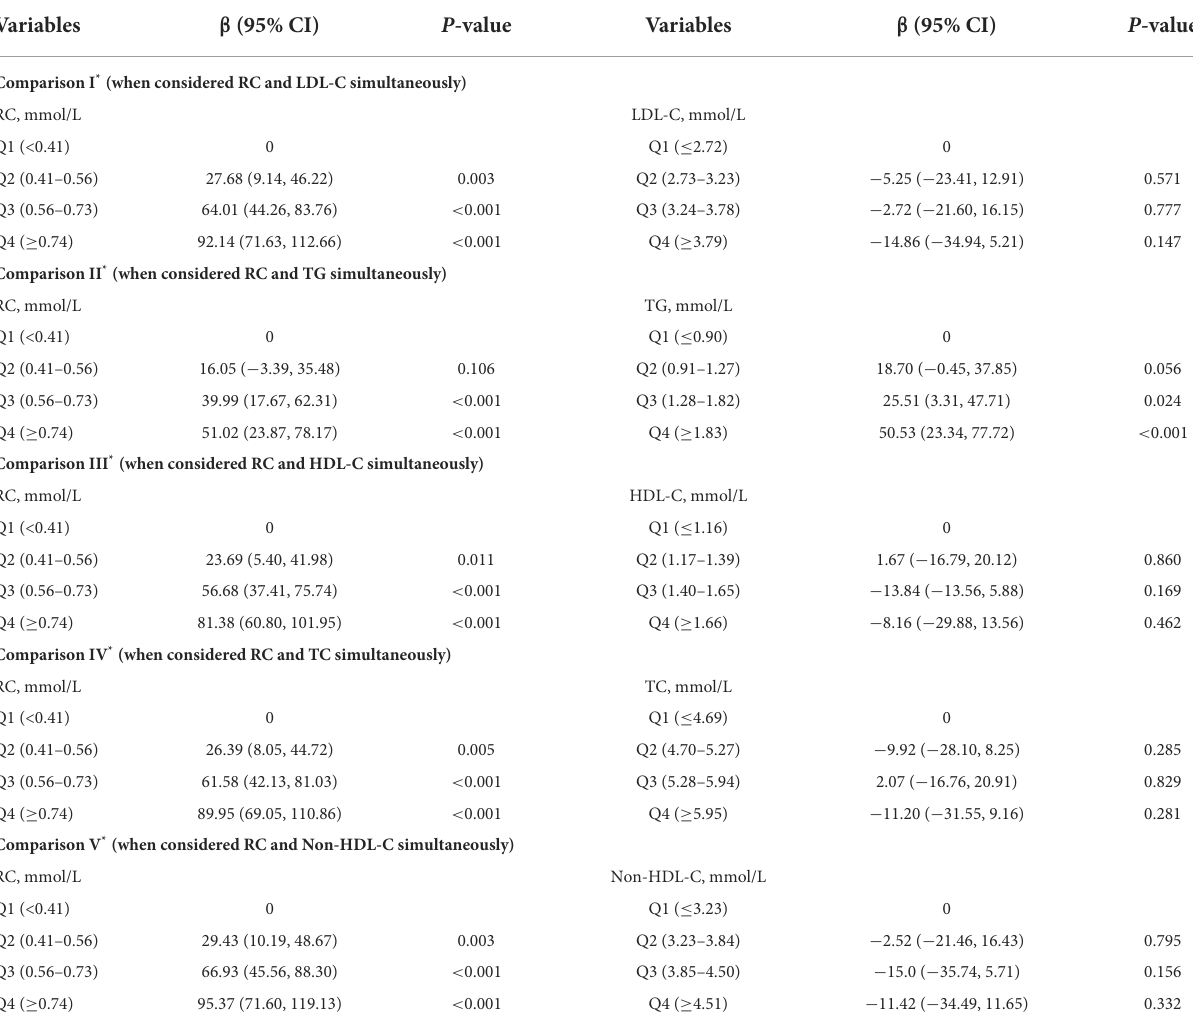
TABLE 3 Associations between brachial-ankle pulse wave velocity and lipids with RC and other lipids entered into the model simultaneously. Variables β (95% CI) P -value Variables β (95% CI) P